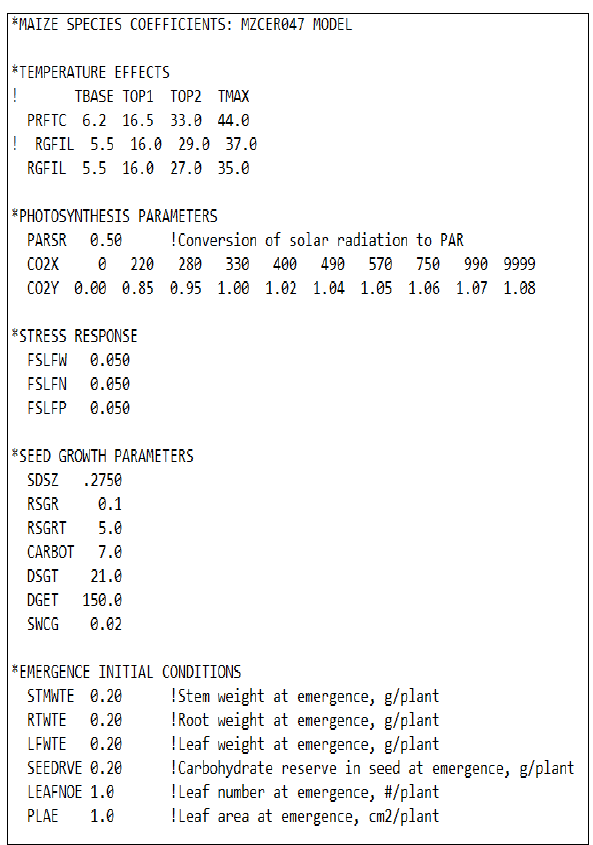
Figure 9. Species data in DSSAT